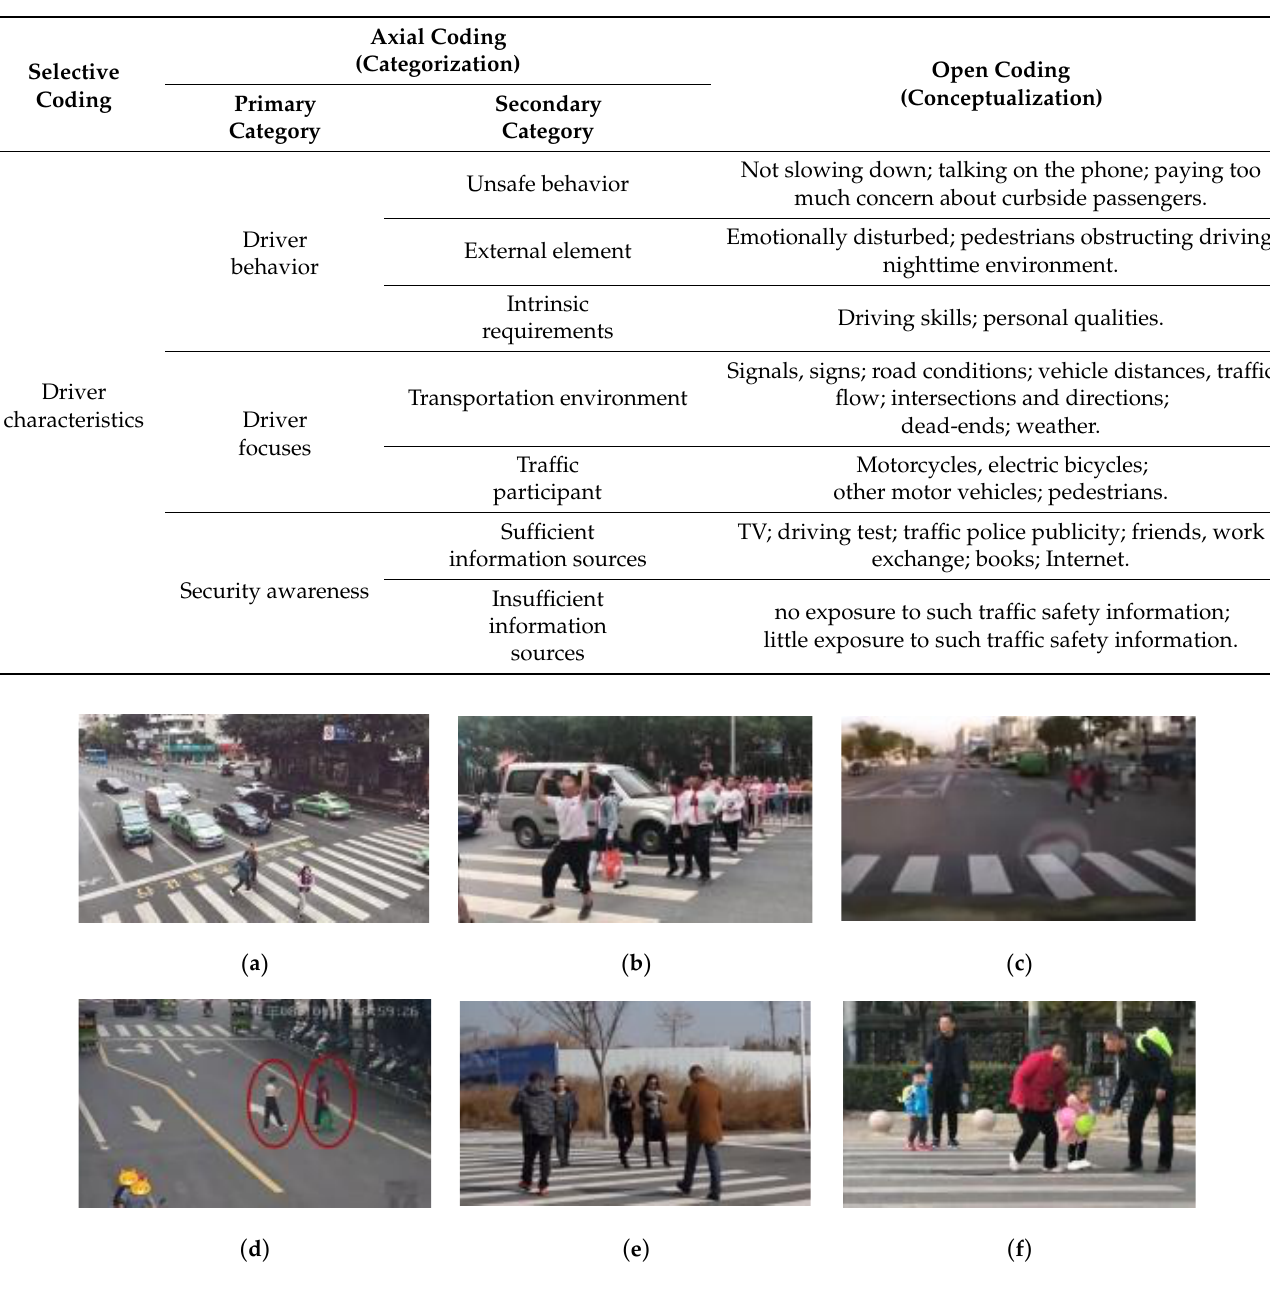
Figure 3. Examples of pedestrian violations. ( a ) Children running; ( b ) playing and chatting; ( c ) children running; ( d ) cross before crosswalk; ( e ) swiping phone; ( f ) rushing with children.